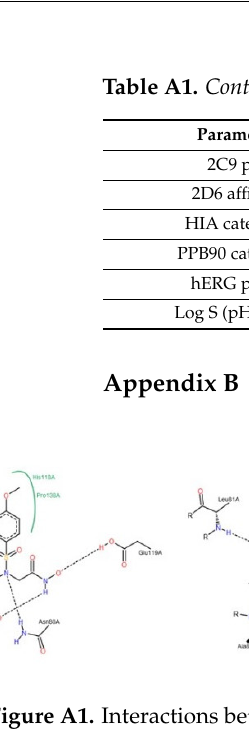
Figure A3. Interactions between NNGH inhibitor and MMP-8, by PoseView calculations.